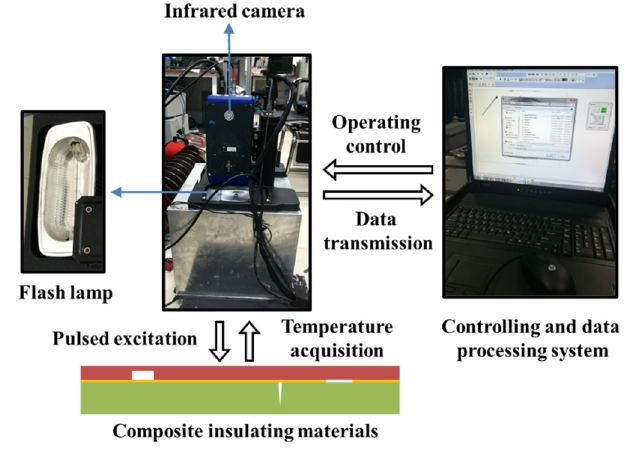
Figure 5. Experimental facilities and working principle.